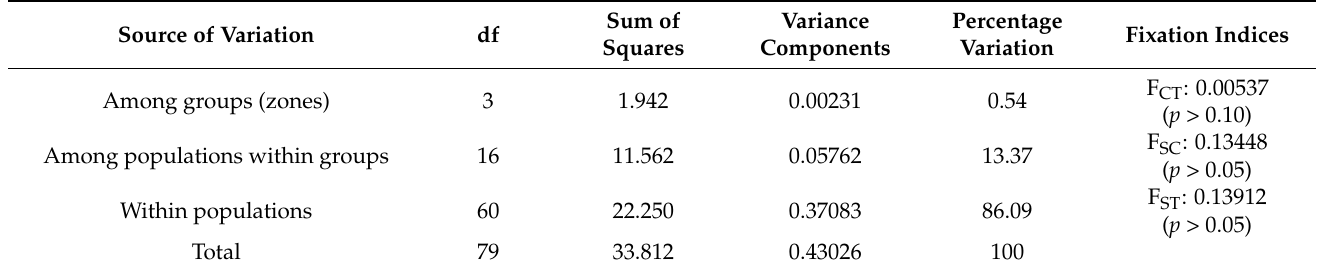
Table 3. Analysis of molecular variance (AMOVA) for the COI sequences of different M. vitrata populations.